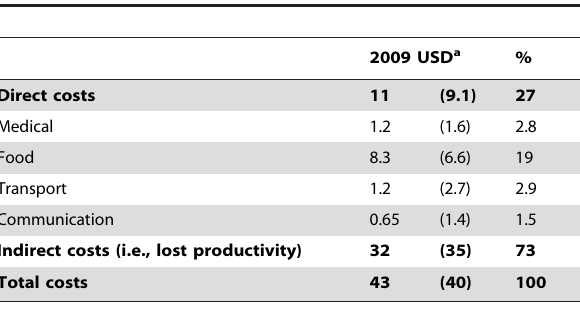
Table 4. Private direct and indirect costs of illness for cholera, Zanzibar,